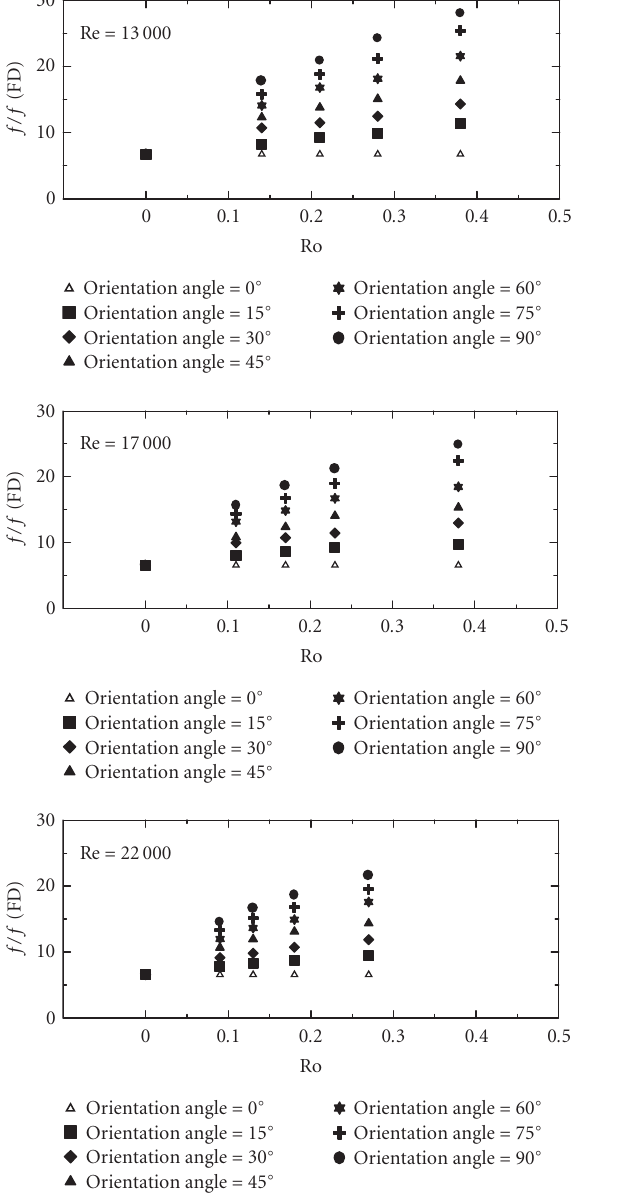
Figure 6: E ff ect of the orientation angle for 90 ◦ ribbed radial out- ward flow channel for a rib pitch-to-height ratio of